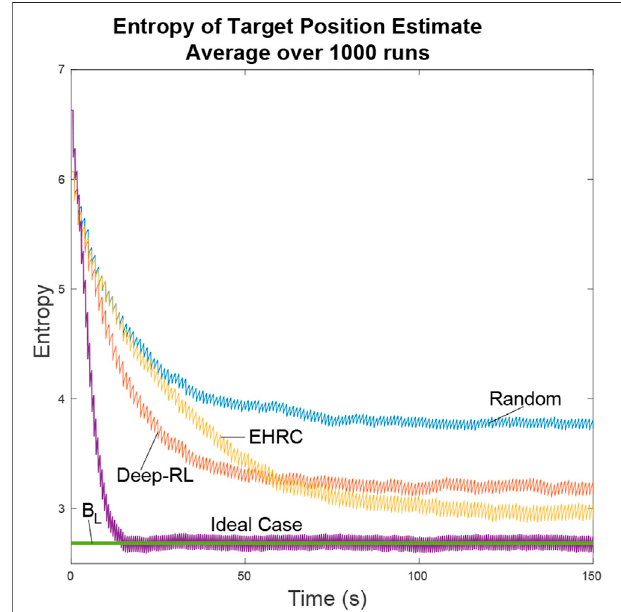
FIGURE 11 | The ideal scenario and the lower bound are included for comparison. In the ideal scenario the UAV is always aware of the actual positions of the targets and fl ies directly between the two. The Lower Bound describes the average lower bound for entropy. We can see that the neural net path planner dropped in entropy faster than the exhaustive path planner. This is because the neural net learned ef fi cient search patterns for uniformly distributed particles while the exhaustive path planner only made ef fi cient decisions after it knew the general locations of the